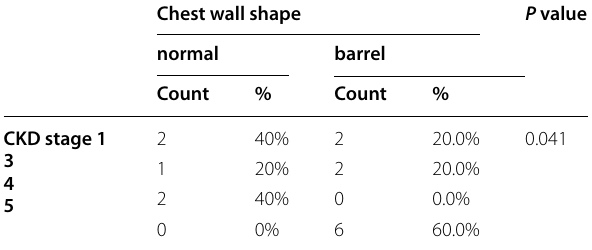
Table 3 Relation between chest wall shape and CKD stage Chest wall shape